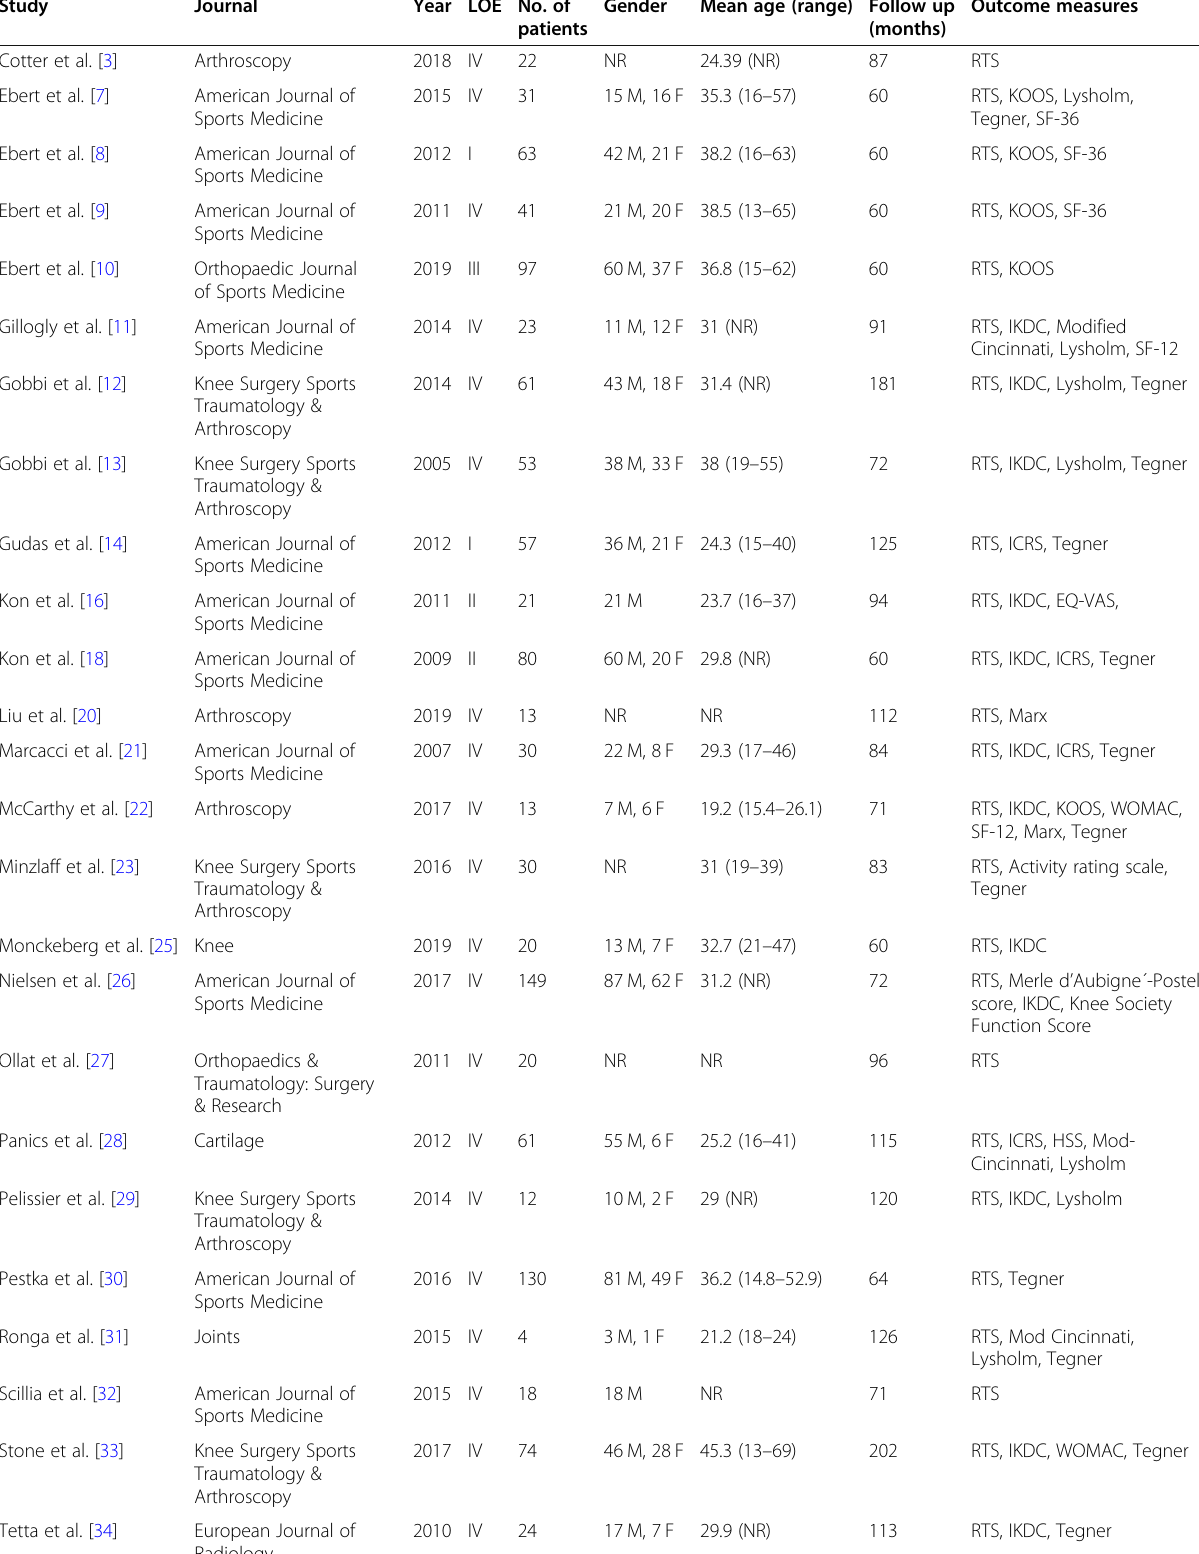
Table 1 Patient demographics and outcome measures of included studies